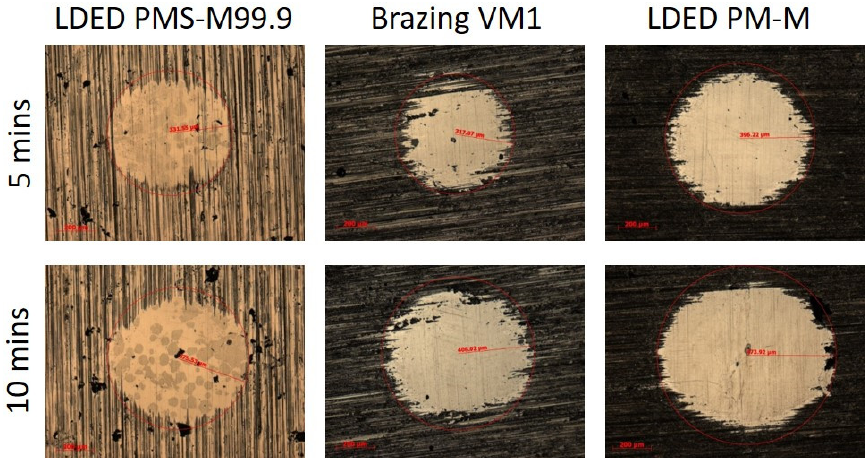
Figure 15. The development of destructive processes in the contact area during abrasive wear tests.